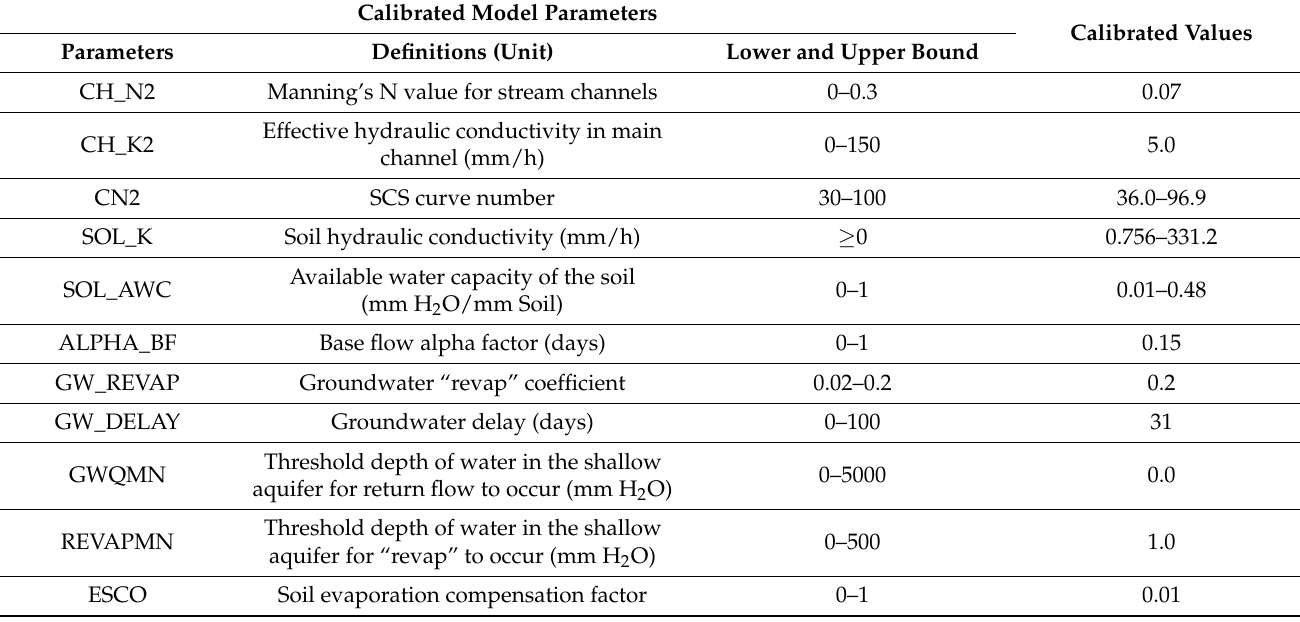
Table 2. Model parameters used to calibrate discharge of Kentucky River at LD14. Ranges of calibrated parameters reflect values for different land use/cover and soil types.